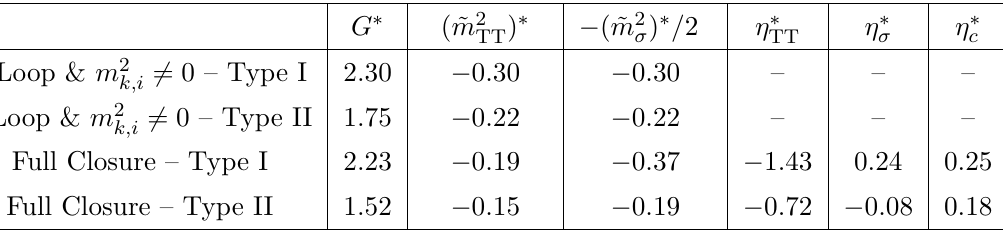
and ~ m 2 . k; TT k;(cid:27)